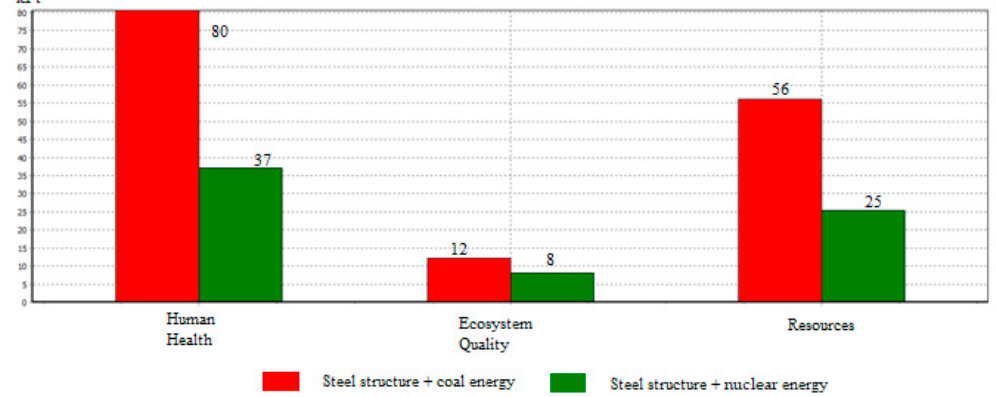
Figure 11. Single score comparison of damage categories caused by the production of the steel structure o ffi ce building with the production of electricity from coal-fired power plants (steel structure +